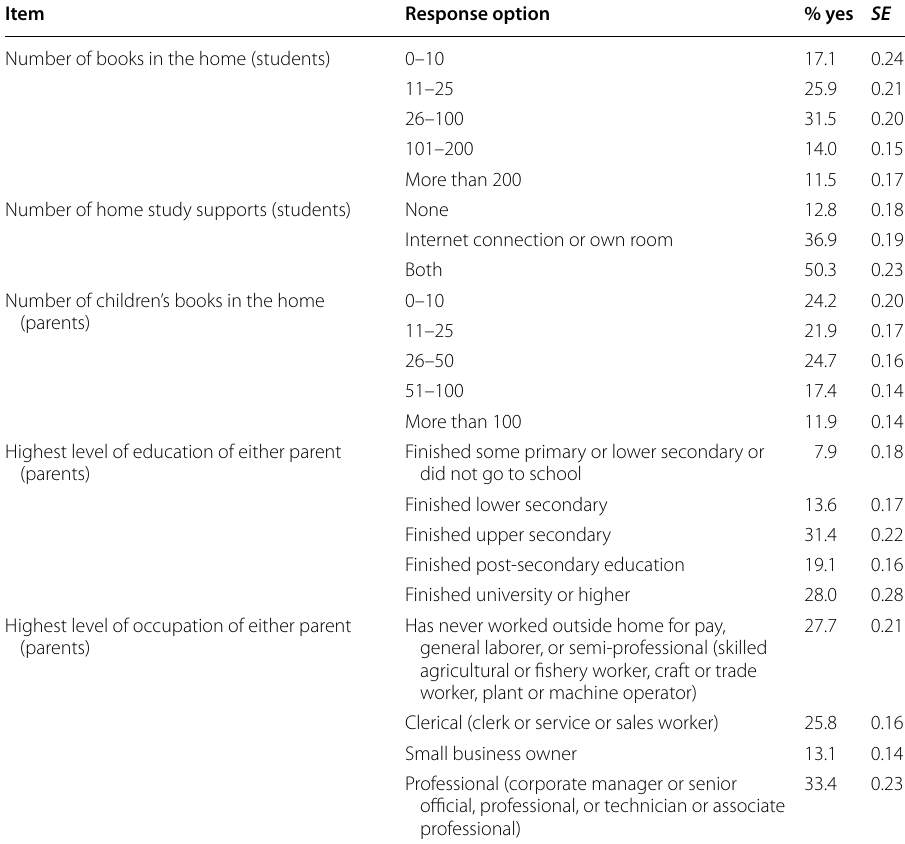
Table 1 Items of the home resources for learning scale (fourth grade) and percentage of yes responses overall countries (n =